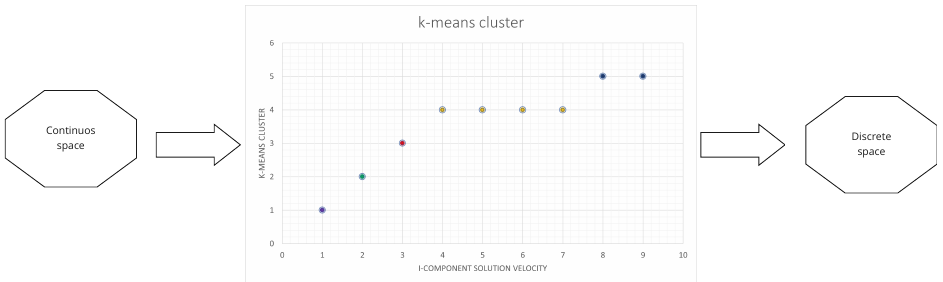
Figure 3. K-means discretization technique